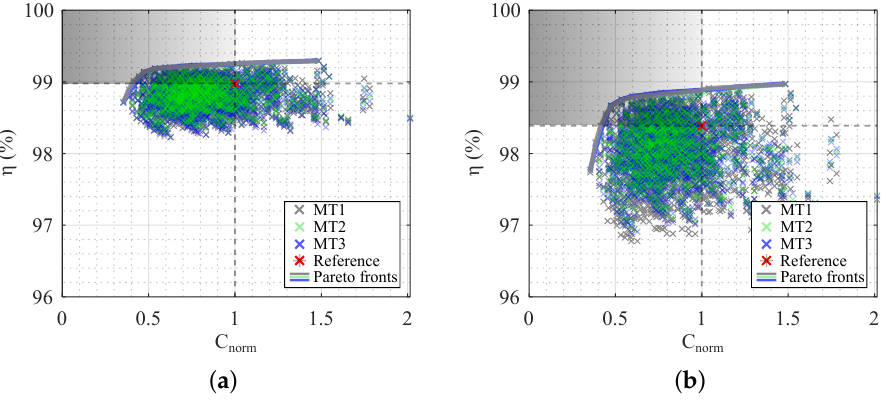
Figure 12. Pareto front considering all modulation techniques. ( a ) 500 W. ( b ) 800 W. The shaded area contains 403 designs with η ≥ η ref and C norm ≤ C ref . As can